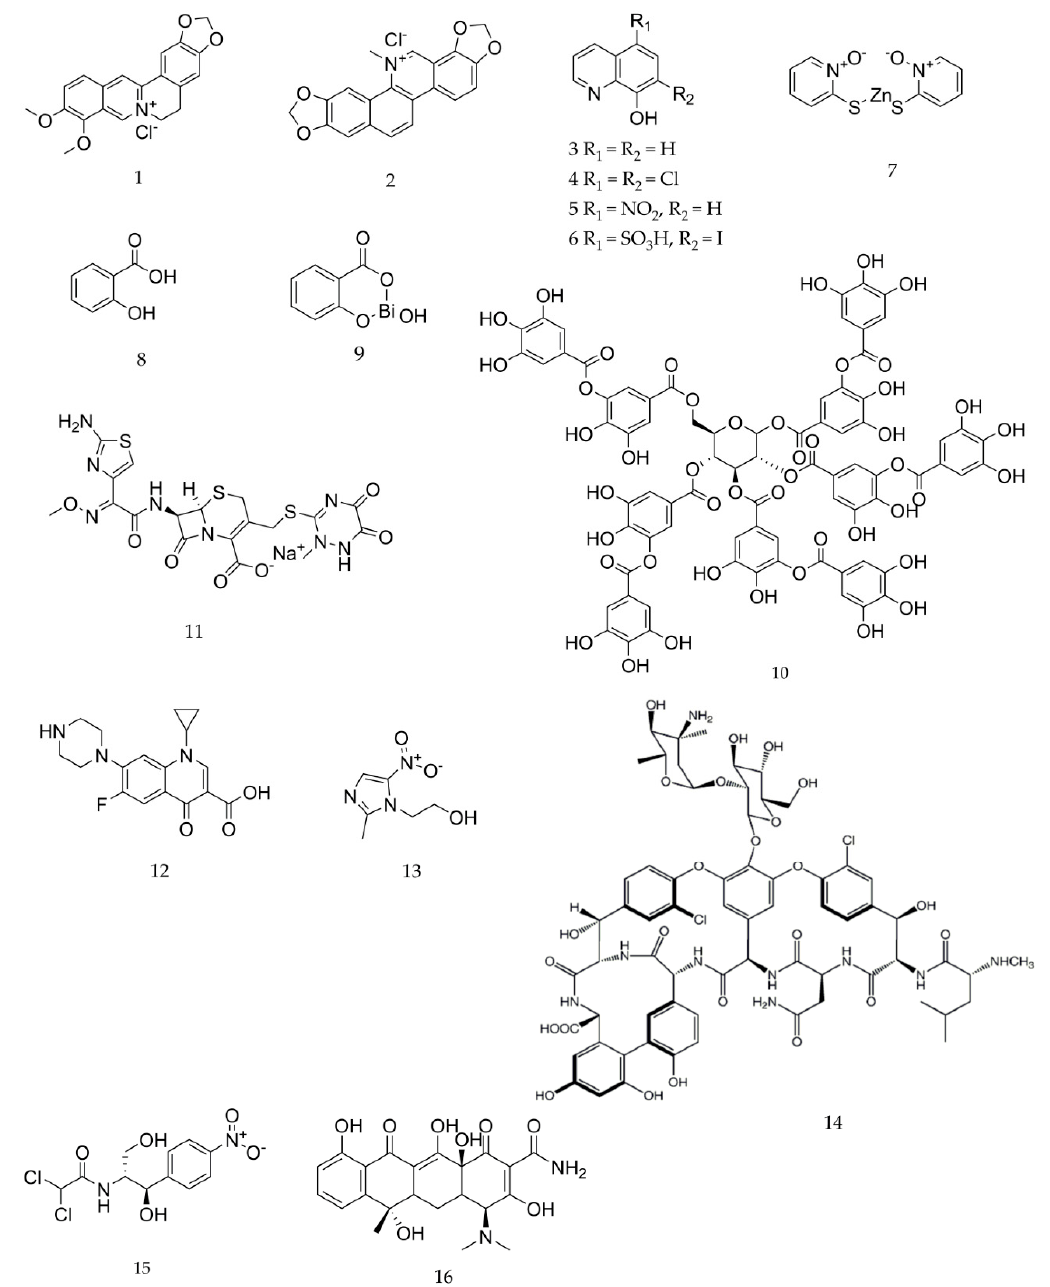
Figure 3. The chemical structures of the tested phytochemicals, their synthetic analogs, and antidiarrheal antibiotics. 1 . berberine chloride, 2 . sanguinarine chloride, 3 . 8 ‐ hydroxyquinoline, 4 . chloroxine, 5 . nitroxoline, 6 . ferron, 7 . zinc pyrithione, 8 . salicylic acid, 9 . bismuth subsalicylate, 10 . tannic acid, 11 . ceftriaxone sodium, 12. ciprofloxacin, 13 . metronidazole, 14 . vancomycin hydrochloride, 15 . chloramphenicol, 16 .